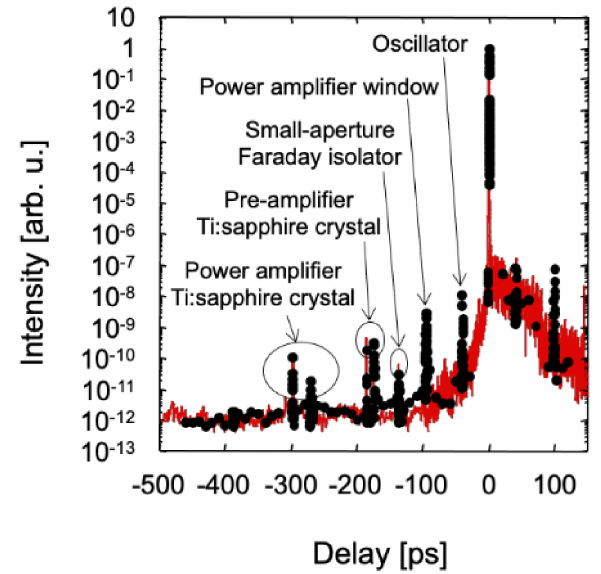
Figure 10. Measured contrast of the J-KAREN-P laser system. The red line and black, filled circles were obtained with the output energies of ~1 J and ~10 J, respectively, showing identification of the artificial and real pre-pulses generated by the